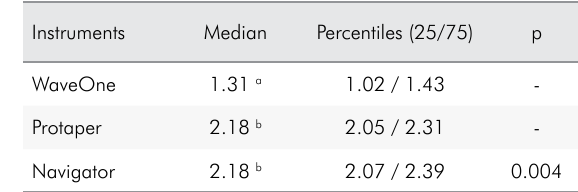
Table 2. Median and percentiles (25/75) of preparation time